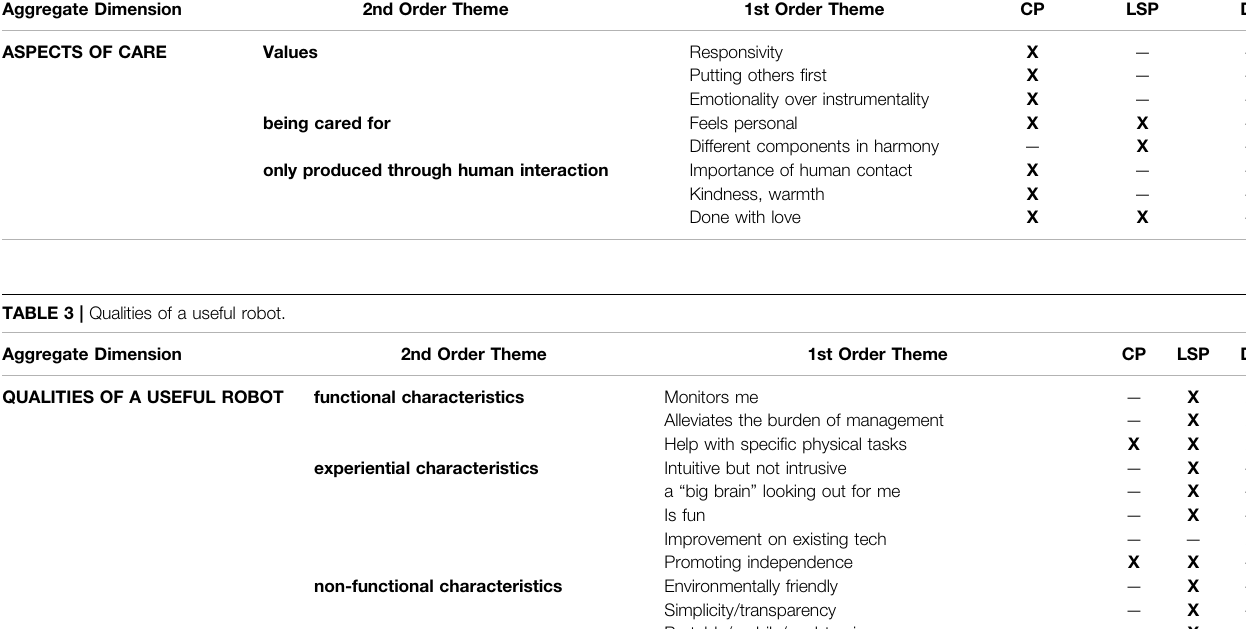
TABLE 2 | Aspects of care. Aggregate Dimension